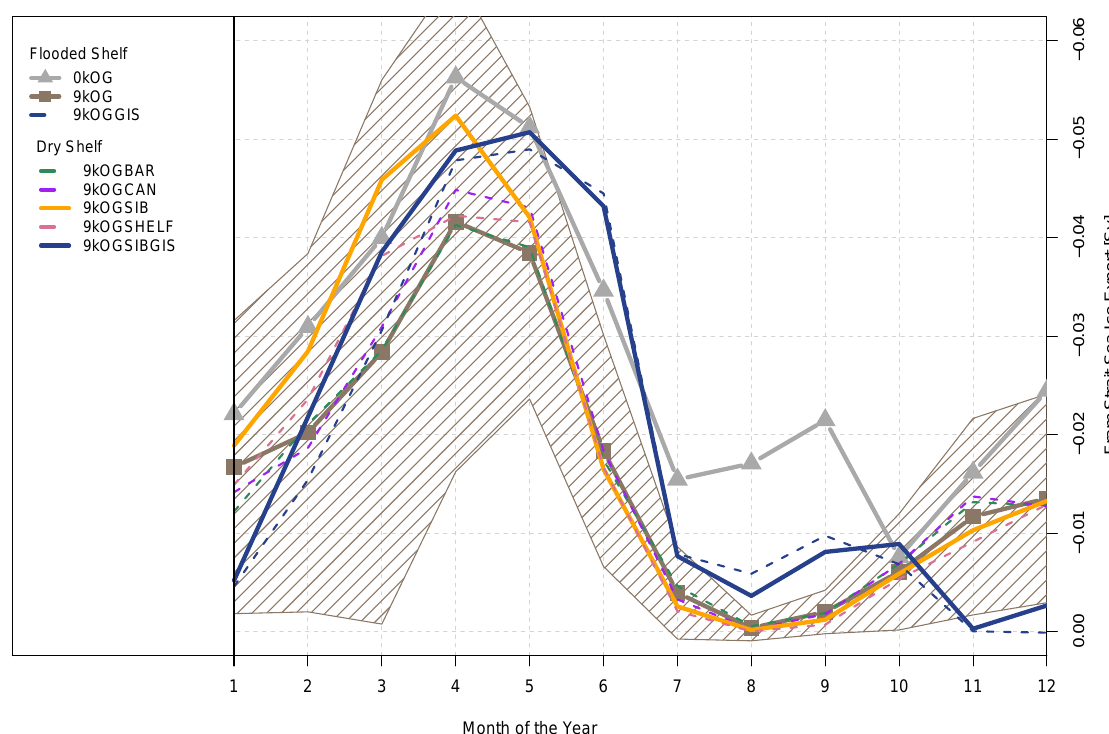
Fig. 3. Monthly mean Fram Strait sea-ice export for different simulations in Sv of the last 100yr. The more negative the values are the more southward transport occurs. In the literature values are normally given as yearly exports, resulting from a sum of monthly values (cf. Table 2). Shaded area gives an estimation of the standard deviation of the monthly means for simulation 9kOG.